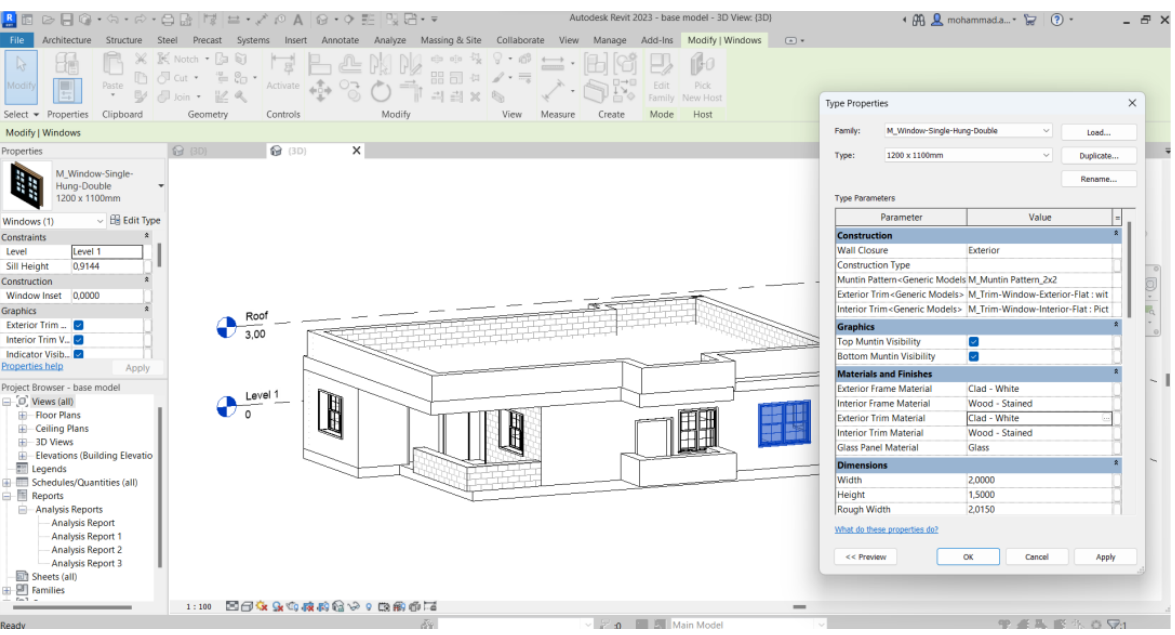
Figure A4. Windows ’ energy analytical properties (Case 1).